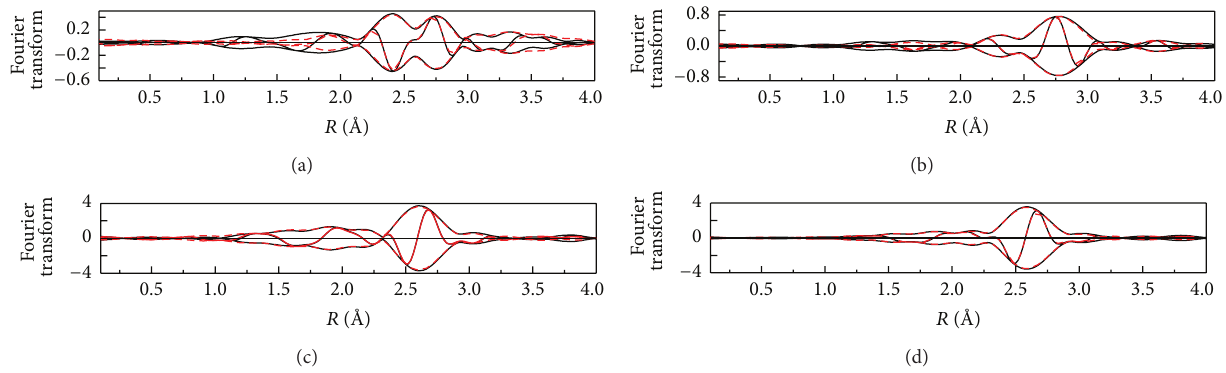
−1 , Pt-Pt phase and amplitude −1 ,